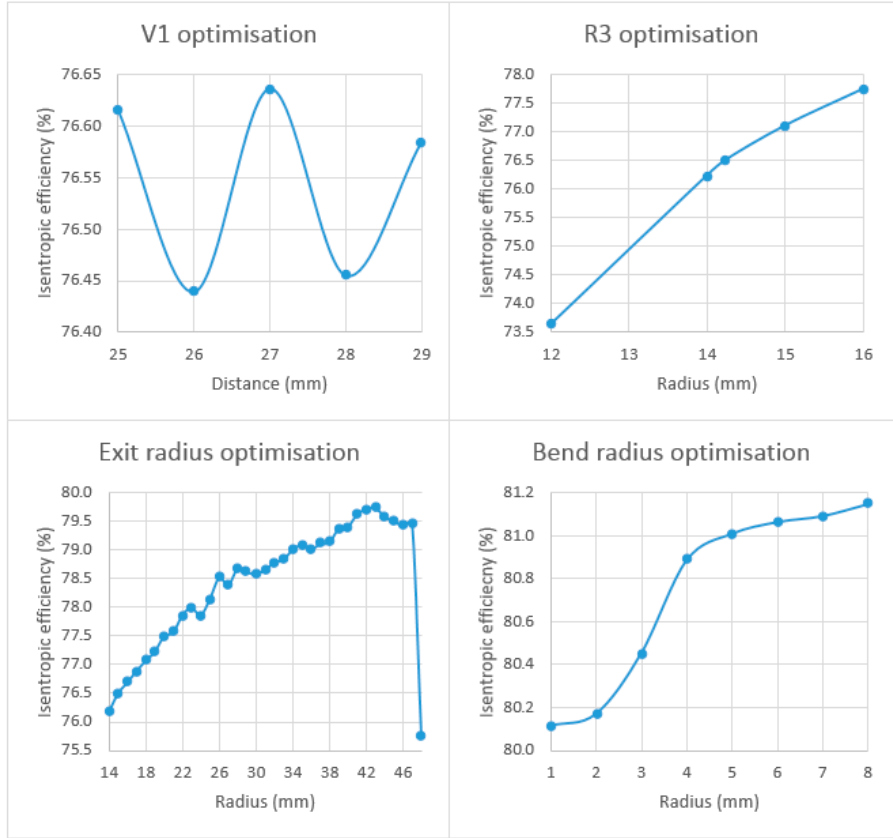
Figure 11. Results of the second stage of the parametric volute optimisation process.